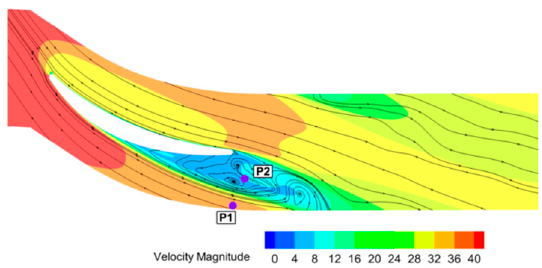
Figure 12. Monitor point location and contour of velocity magnitude at 20% span.